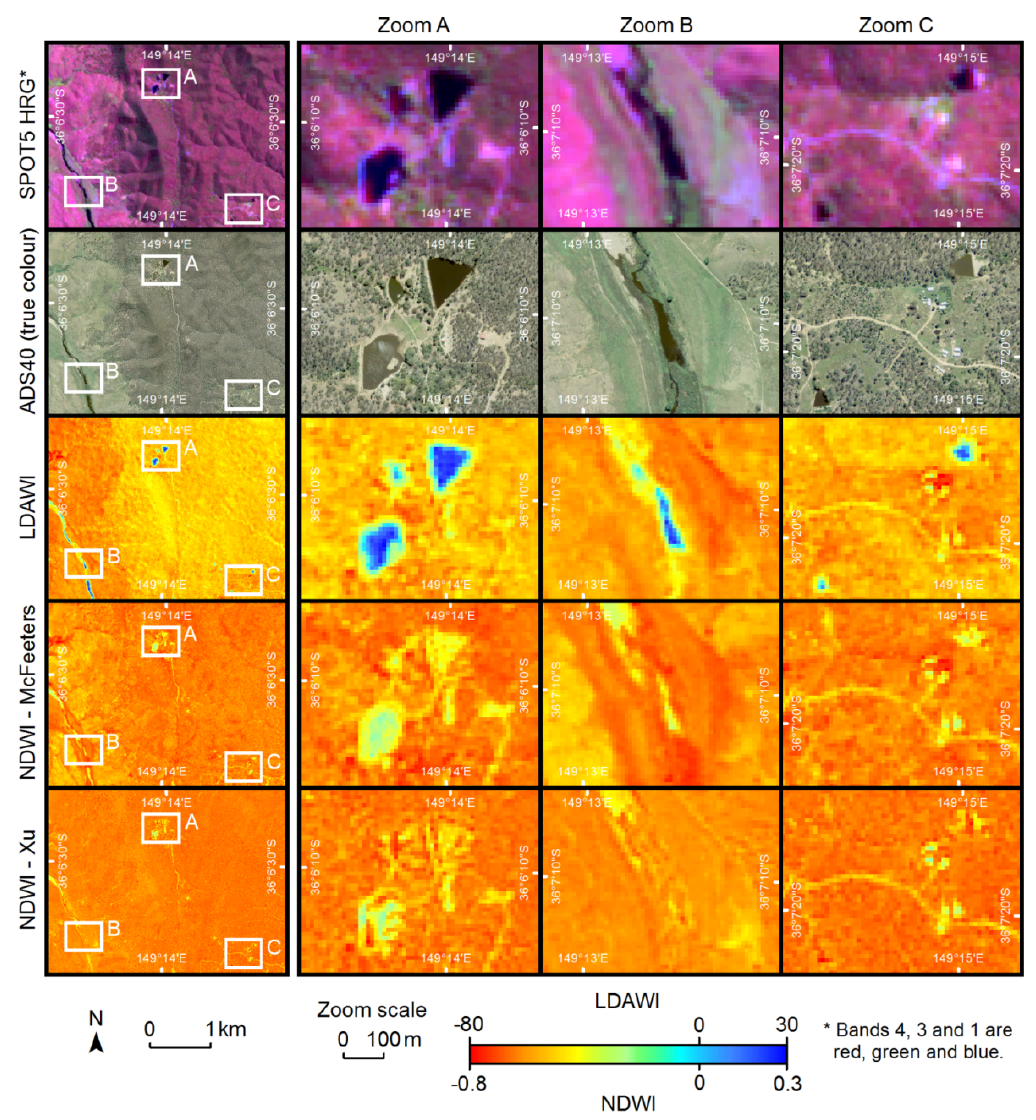
Figure 6. Three examples of where the linear discriminant analysis water index (LDAWI) performs better than the normalized difference water index (NDWI) of McFeeters or Xu in detecting small water bodies, for a subset of the Cooma image (Figure